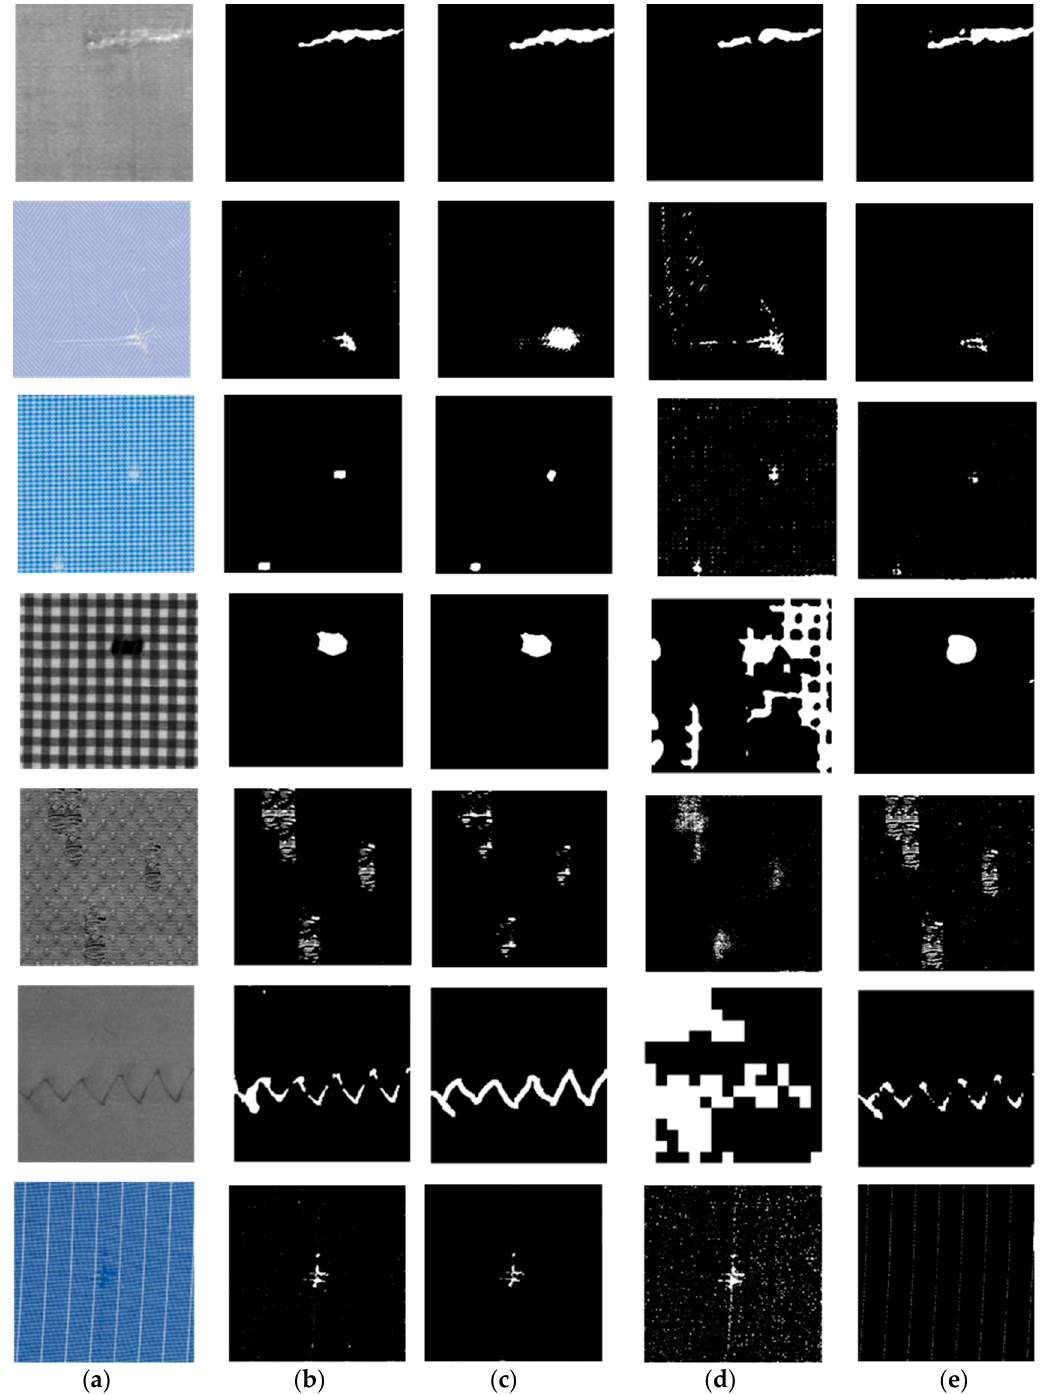
Figure 17. Various texture fabric defect detection results using di ff erent methods ( a ). Di ff erent fabric type defects ( b ). Our method ( c ) carried out by human inspectors. ( d ) The automatic band selection method [6]. ( e ) The EADL method [5].